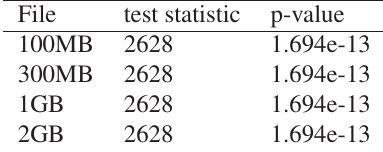
Table 2. Test results.